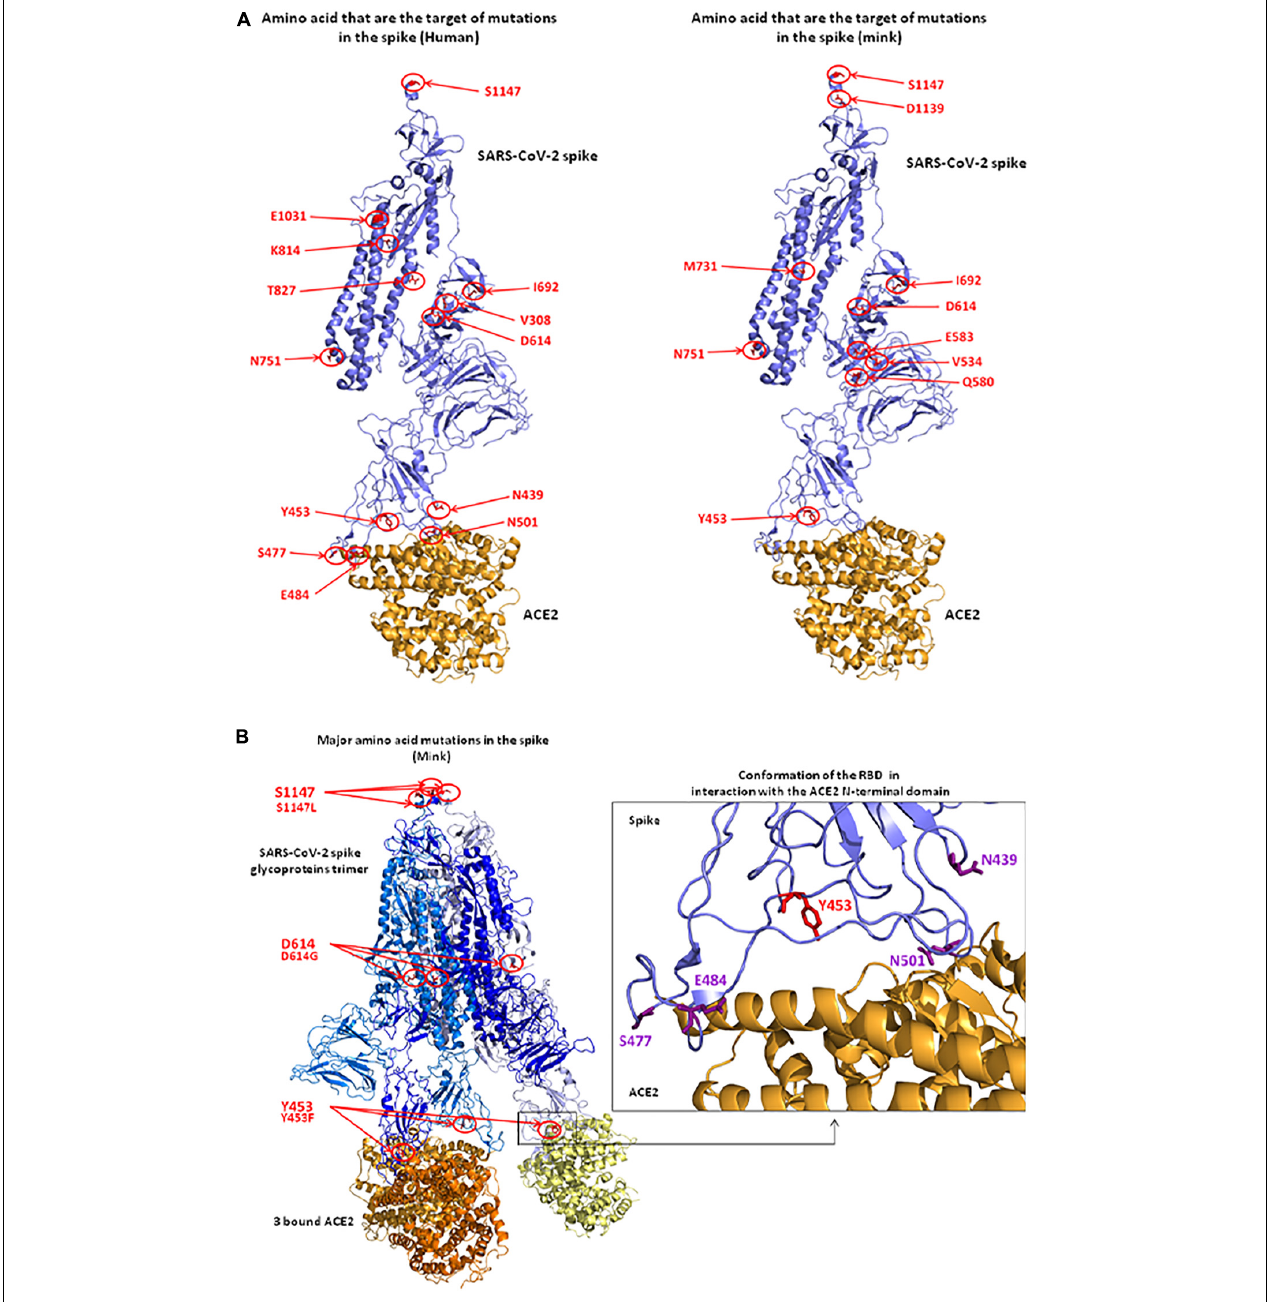
FIGURE 8 | 3D structure of the SARS-CoV-2 spike protein complexed with ACE2. (A) Positions of observed mutant residues in human (left) and mink (right) SARS-CoV-2 spike proteins. In the published 3D structure (PDB: 7A98) (Benton et al., 2020), the spike glycoprotein is colored in blue and the bound ACE2 receptor is colored in orange. The main mutant amino acids are colored in red and their positions are indicated with red circles and arrows. (B) Representation of the SARS-CoV-2 spike trimer (SARS-CoV-2 sequence from mink) in interaction with ACE2 molecules (left). Representation of the conformation of RBD in interaction with the N-terminal domain of ACE2. The Y453 amino acid that was changed to F453 after the infection of minks (right).